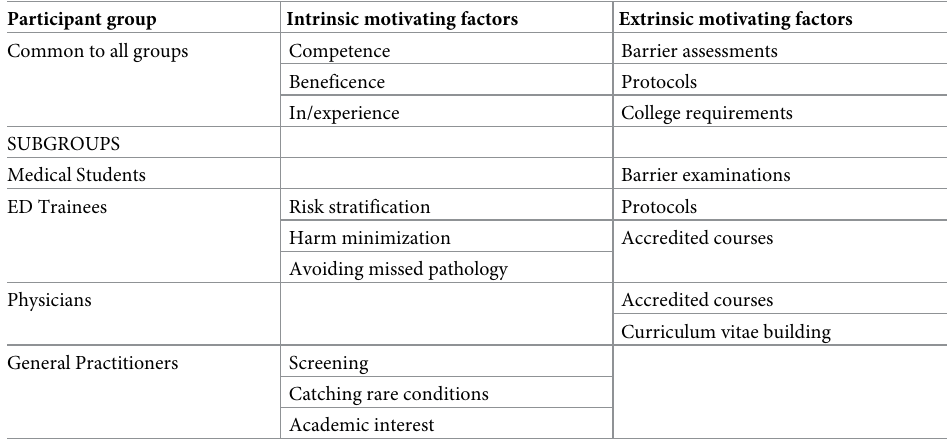
Table 2. Factors affecting motivation to perform clinical examinations such as fundoscopy: Common to all groups, and; particularly noted amongst different clinical groups. Participant